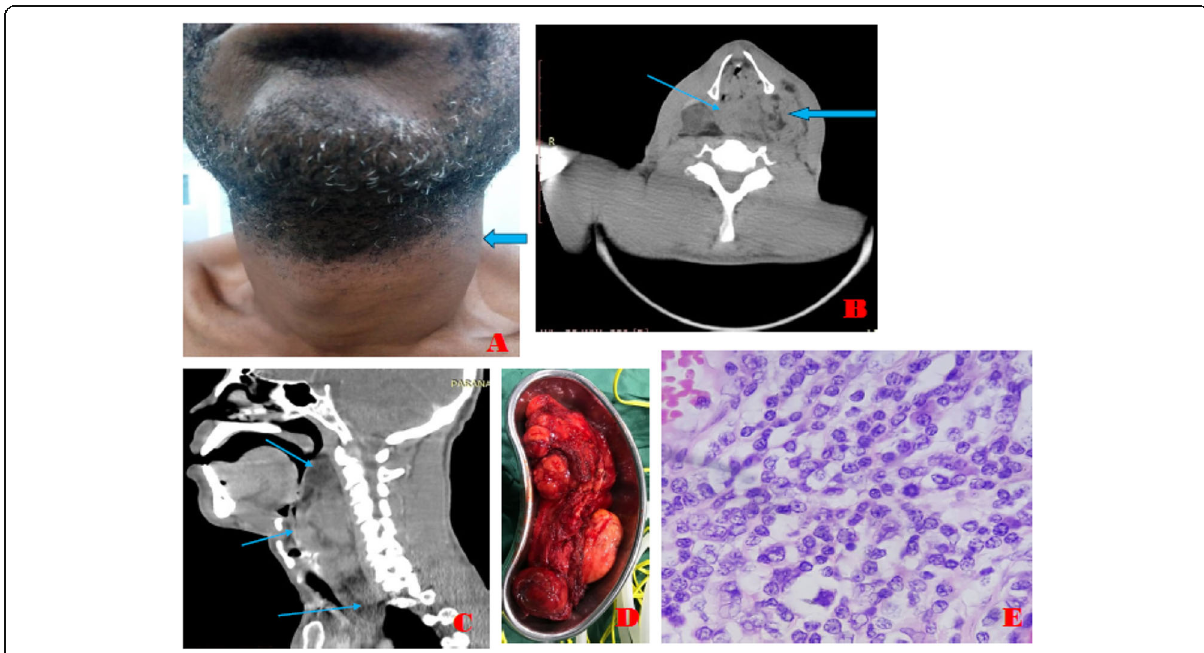
Fig. 1 A Left neck swelling. B Axial neck CT scan showing huge retropharyngeal mass compressing and narrowing the airway and extending into the left parapharyngeal space. C Sagittal view showing lobulated isodense mass from the skull base to the superior mediastinum compressing the upper aerodigestive tract. D Post-operative specimen of multi-lobulated mass with fatty, muscular, fibrous and mixed consistency